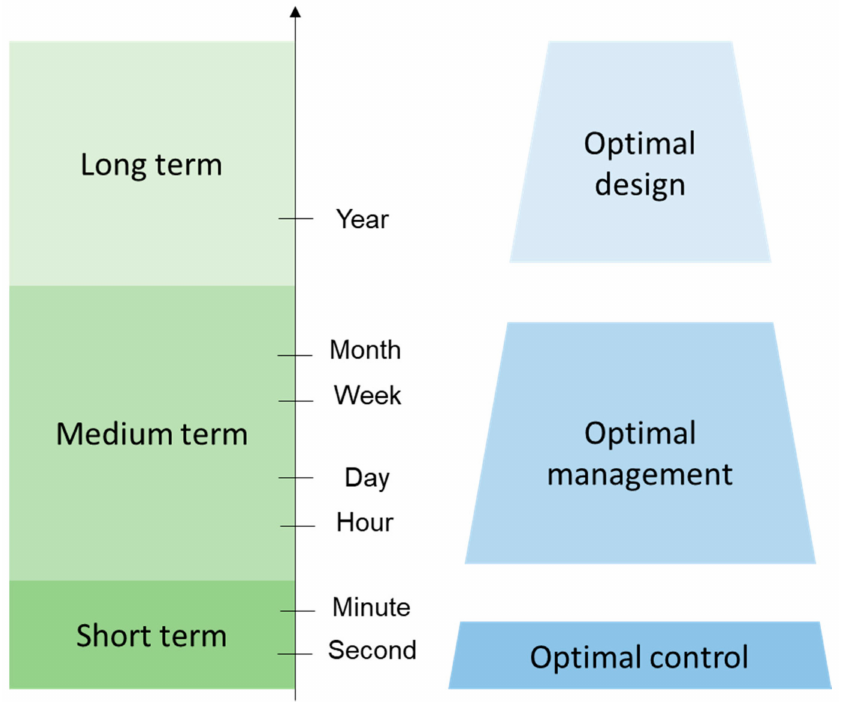
Figure 7. Different time horizons in optimal design, optimal management and optimal